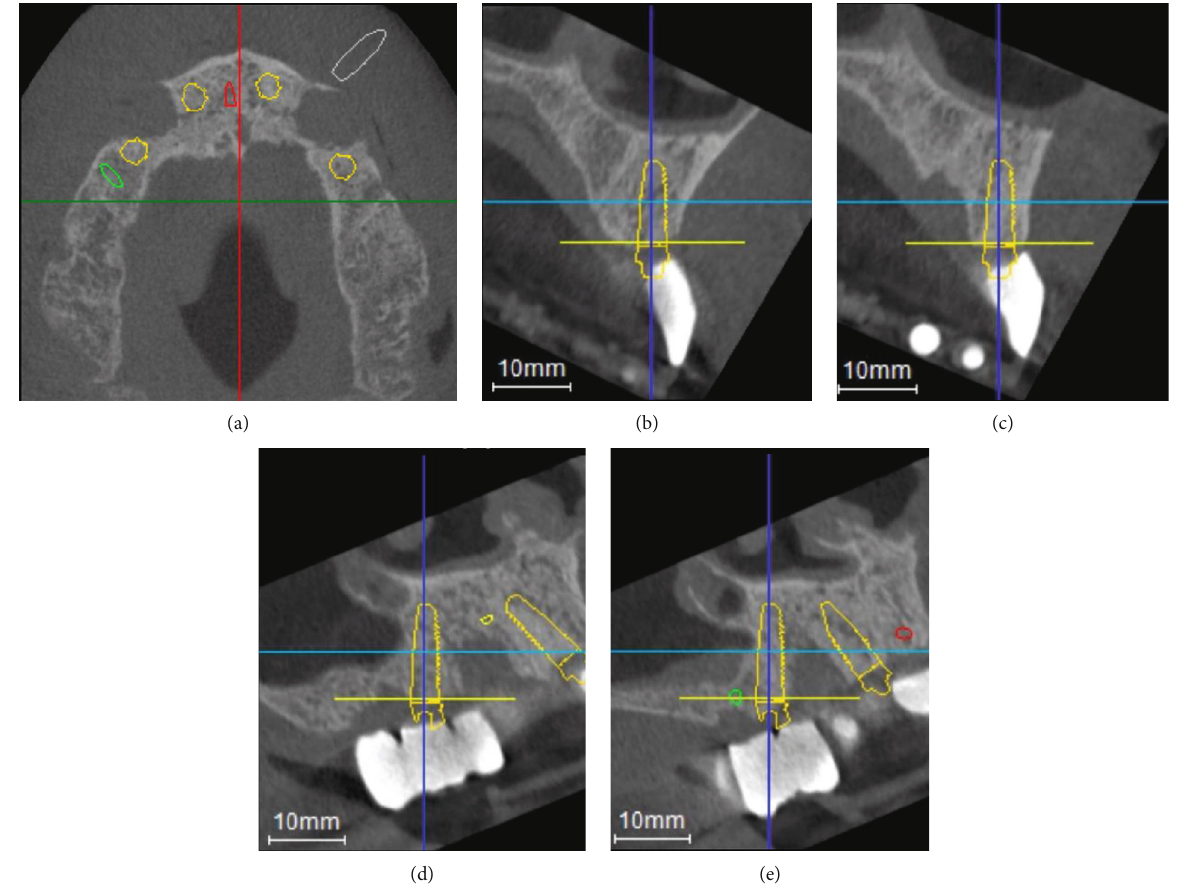
Figure 4: (a) Axial view of all planned implants. (b) Transversal view of planned implant 12. (c) Transversal view of planned implant 22. (d) Transversal view of planned implant 25. (e) Transversal view of planned implant 15.